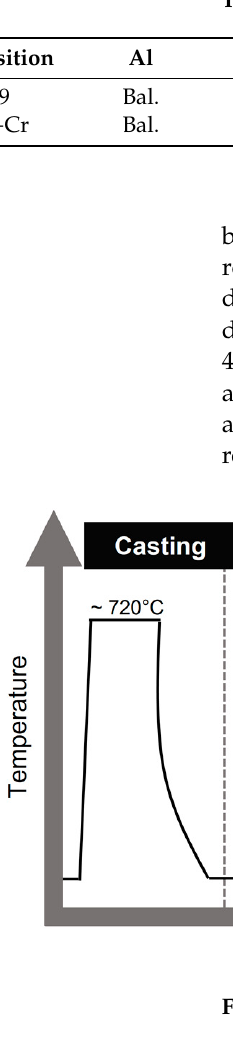
Table 1. Composition of alloys (in wt.%).